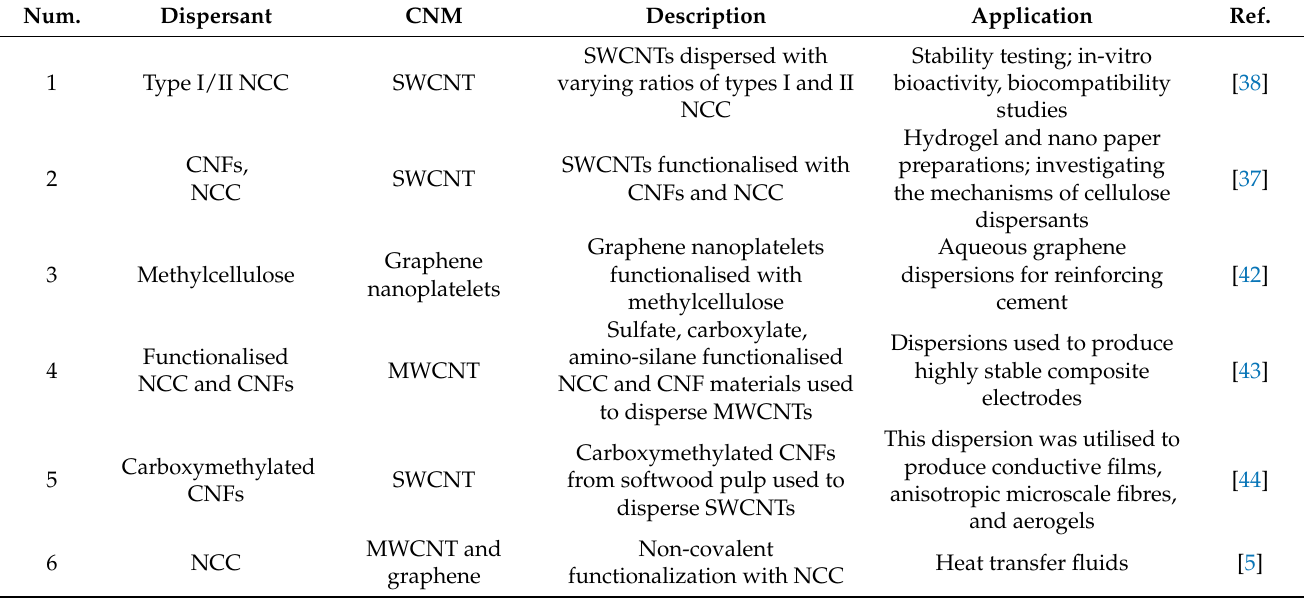
Table 2. Cellulose-based CNM